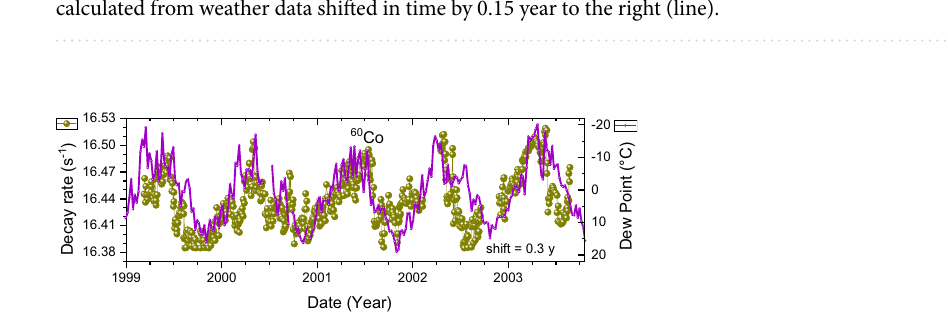
Figure 8. Averaged decay-corrected count rates of 60 Co beta decay obtained with an SBM-12 G–M counter (dots) as a function of time, compared to the dew point in Moscow shifted in time by 0.3 year to the right